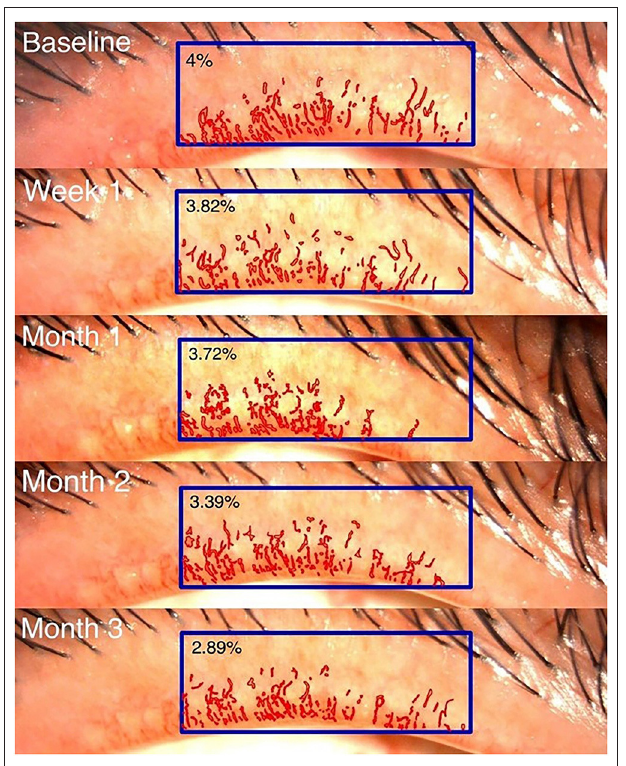
FIGURE 2 | Image of the lid margin neovascularized area.